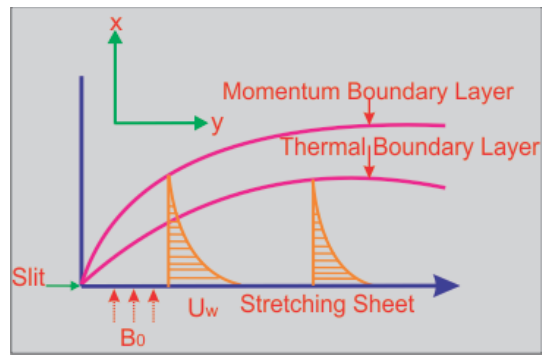
Figure 1. Geometrical description of the